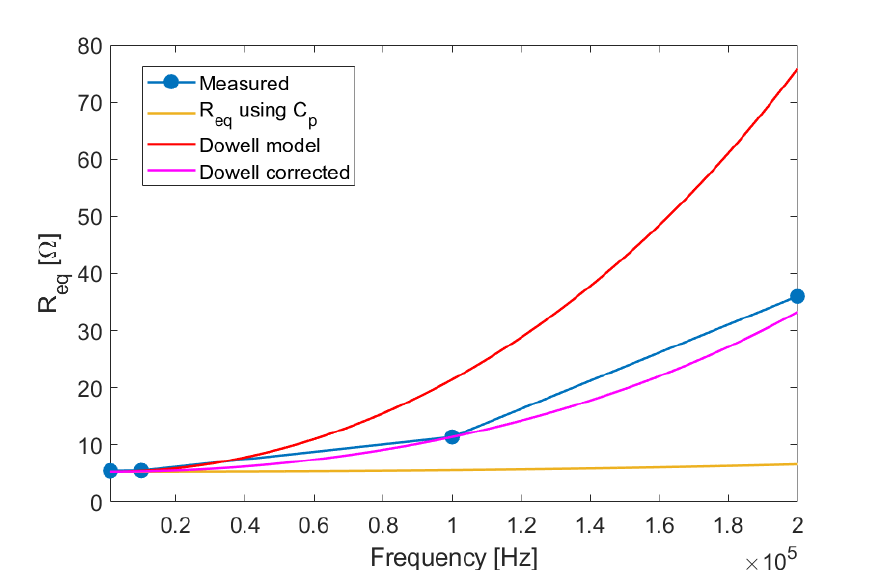
Figure A2. Blue represents the measured resistance of an RX coil. Yellow represents R eq given by Equation (A2). Red represents R eq given by the Dowell model accounting for the skin and proximity effects, using Equation (A3). Magenta represents the Dowell model with corrected porosity